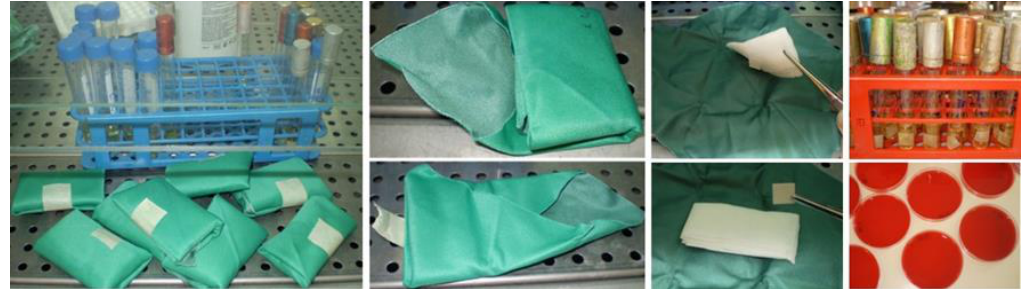
Figure 4. Sterilized packs stored in the warehouse for a period of 1 and 2 months. Presentation of